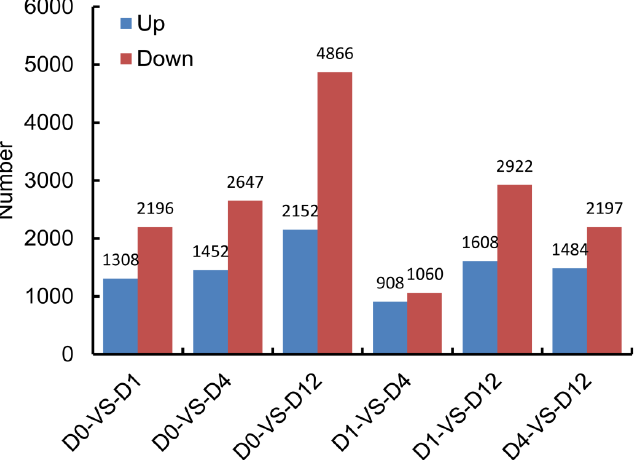
Figure 2. Comparison of DEGs between drought-treated samples.